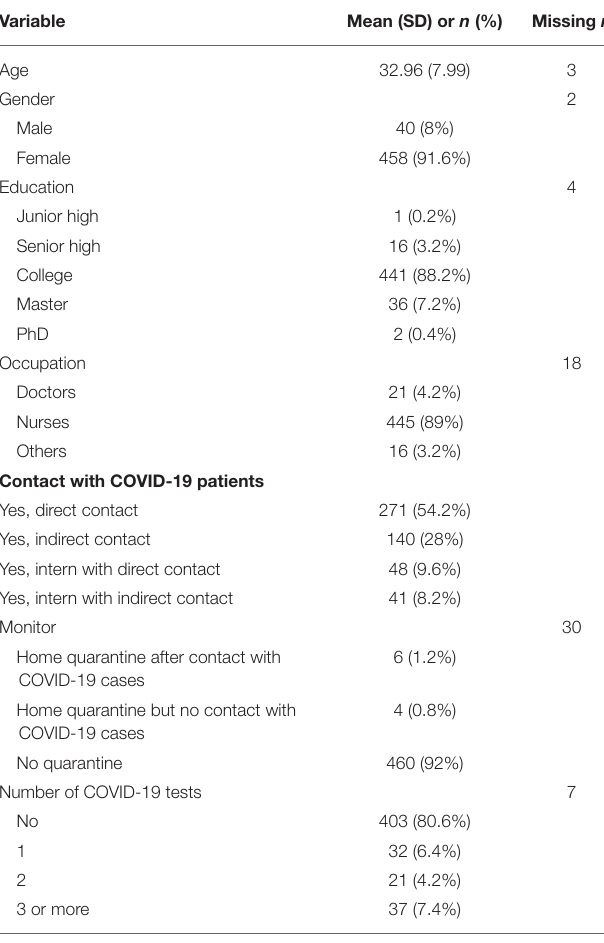
TABLE 1 | Participant characteristics ( n = 500). TABLE 2 | Prevalence of post-traumatic stress disorder symptoms, insomnia, and psychological